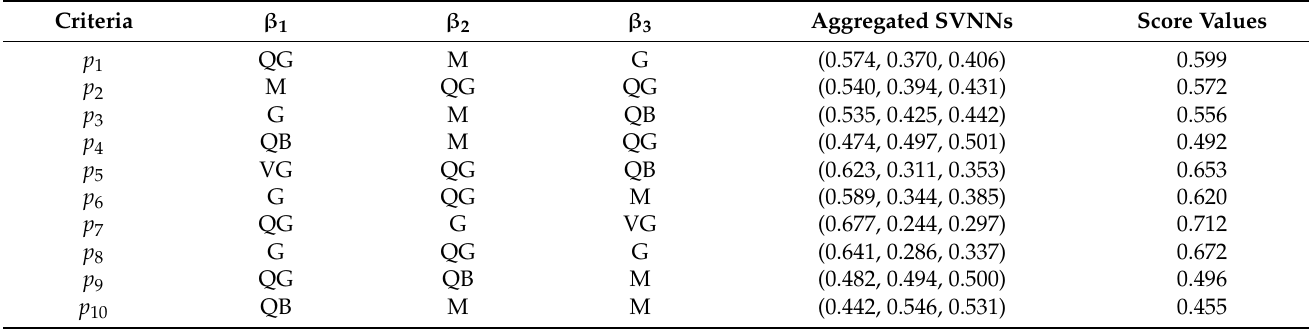
Table 9. Weights of criteria demonstrated by DMs for RESs